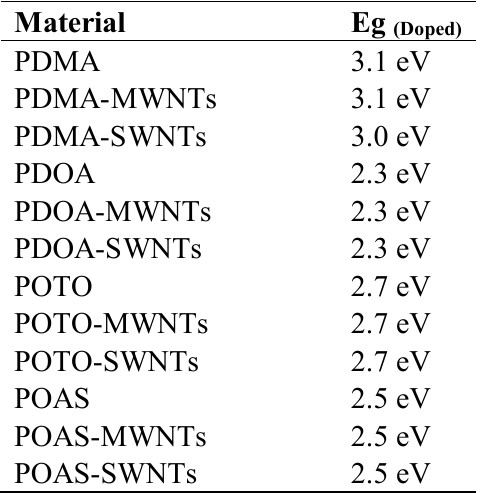
Table 3. Values of the band gaps (Eg ) calculated for the polaron-π* transitions of Doped POTO, POAS, PDOA and related nanocomposites in the doped form. The calculation for PDMA and related nanocomposites was obtained by considering the π-π* transition since, for these materials, the formation of the polaronic state was